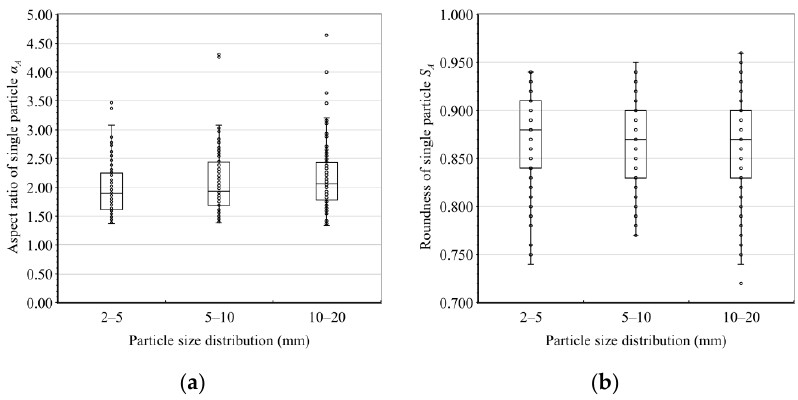
Figure 6. Box plots of the shape parameters. ( a ) The box plot of the aspect ratios. ( b ) The box plot of the roundnesses.